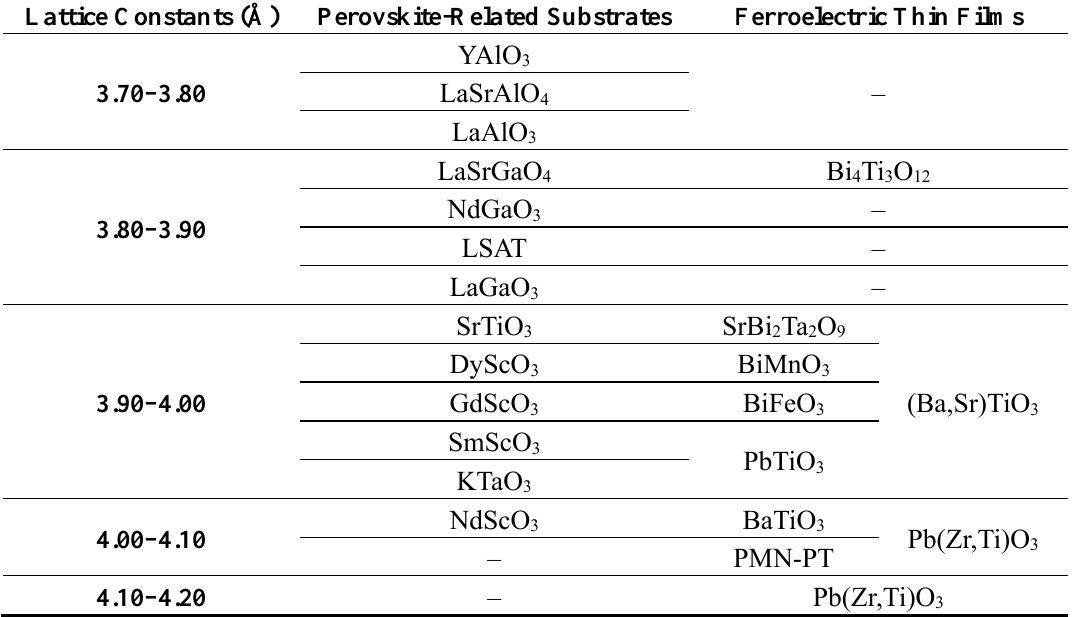
Table 1. Commercially involved perovskite and perovskite-related substrates and the pseudotetragonal or pseudocubic a-axis lattice constants of some frequently-used ferroelectric perovskites. Substrates and thin films which are in the same lines possess similar lattice constants. In one vertical line, lattice constants of thin films or substrates are gradually increasing from top to bottom